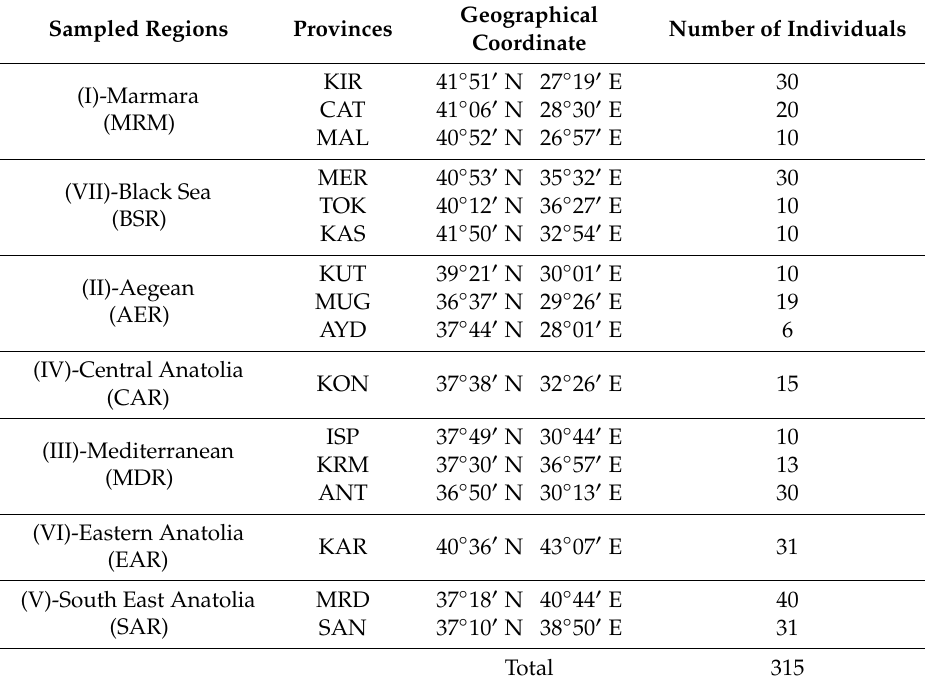
Table 1. The sampled regions, provinces, and the geographical coordinates, with the number of